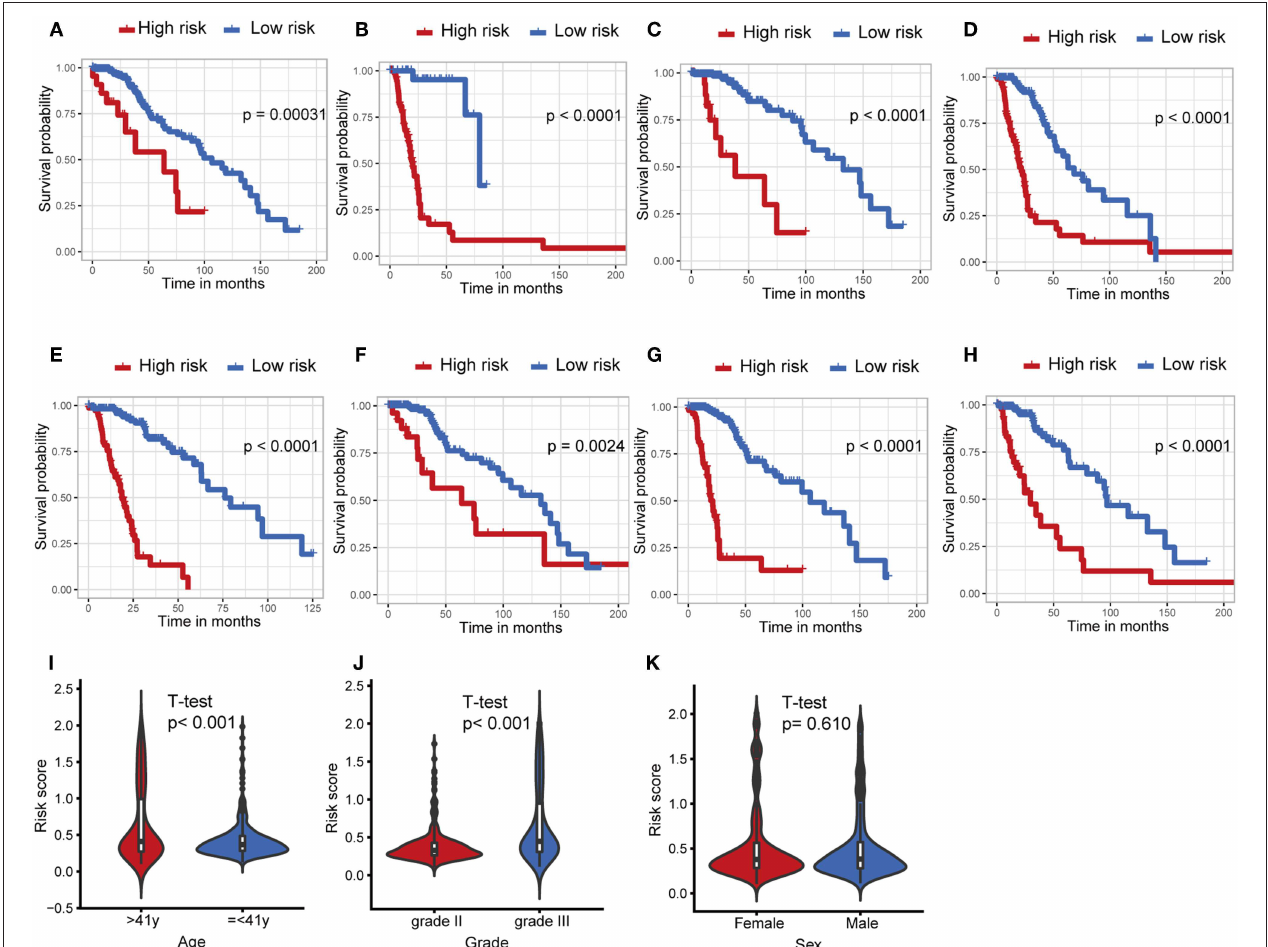
FIGURE 4 | Stratification analysis. The Kaplan–Meier analysis of the IPS grouping according to patients with (A) IDH1 mutant, (B) IDH1 wildtype, (C) grade II, (D) grade III, (E) > 41 years, (F) ≤ 41 years, (G) male, and (H) female. The risk score was group by (I) age, tumor grade (J) , and (K) sex.